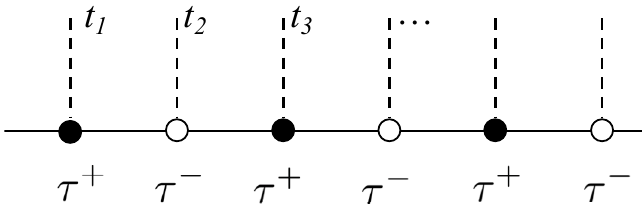
Figure 8: Feynman diagram for the GF before taking averaging over two-component Gaussian random